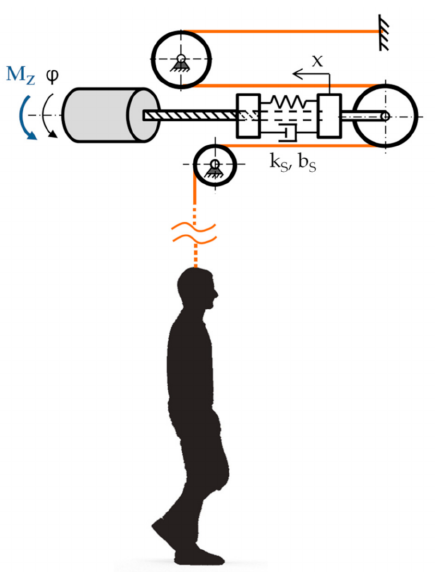
Figure 3. Physical model of the dynamic body weight support